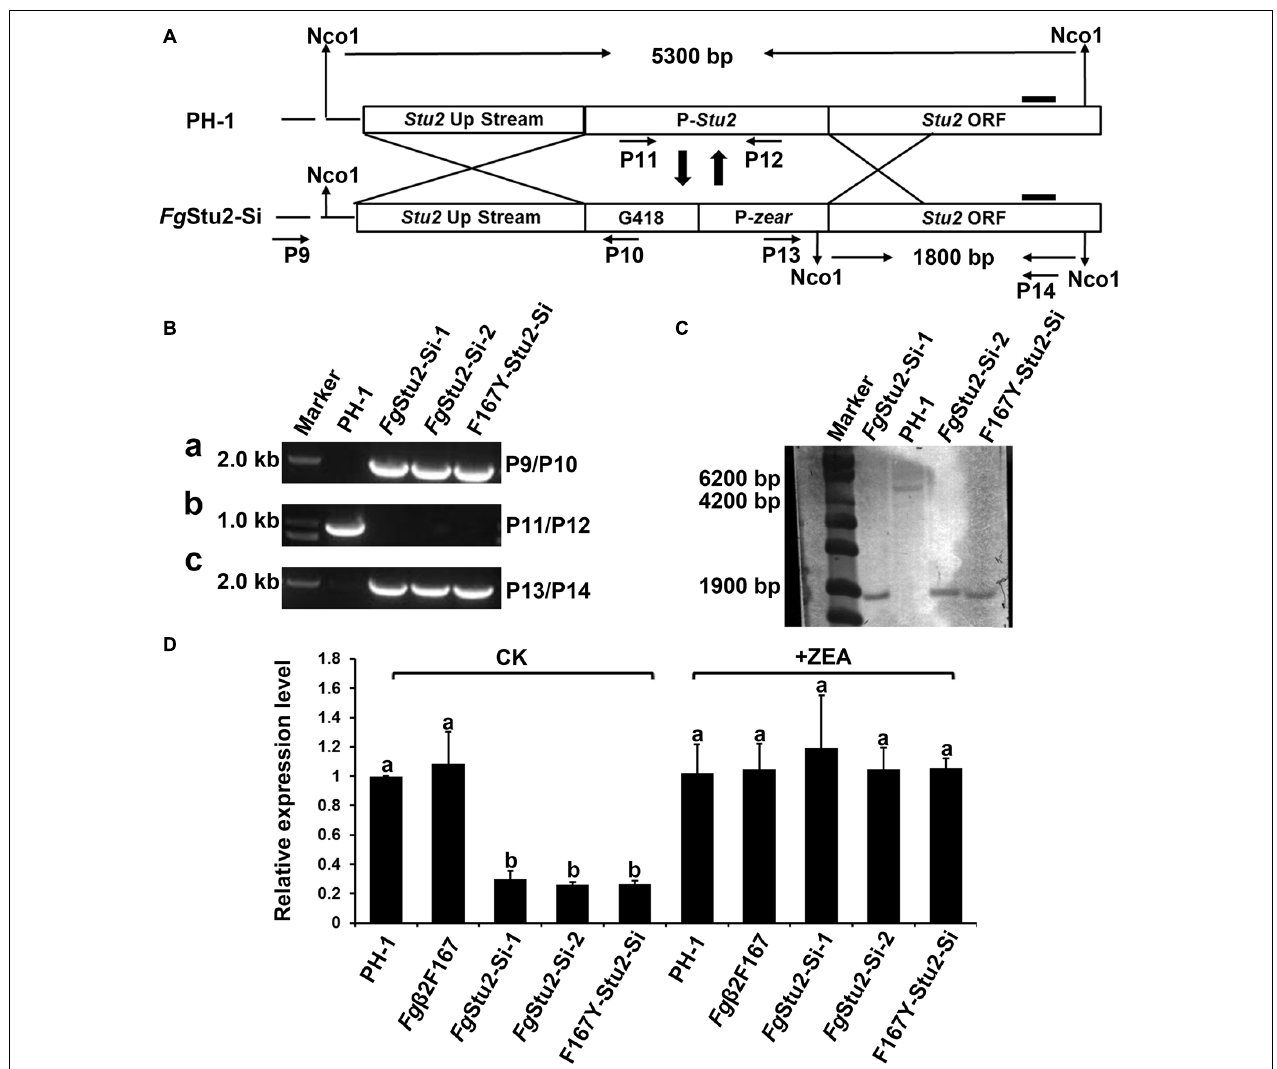
FIGURE 4 | Promoter replacement strategy and identification of promoter replacement mutant of Fg Stu2 gene. (A) Schematic of promoter replacement of Fg Stu2 gene. (B) Polymerase chain reaction (PCR) identification of Fg Stu2 promoter replacement mutants. (a) a 1.9 kb fragment was amplified by primers P9/P10 indicates G418-Pzear fragment integrated at the 3 (cid:48) -terminal of up-stream non-coding sequence of FgStu2 gene. (b) a 0.9 kb fragment could not amplified by primers P11/P12 indicates original promoter of Fg Stu2 has been substituted with G418-Pzear. (C) a 1.8 kb fragment was amplified by primers P13/P14 indicates that G418-Pzear integrated at the 5 (cid:48) -terminal of Fg Stu2 coding sequence (CDS). (C) Southern blot identification of Fg Stu2 promoter replacement mutants. (D) Real-time quantitative PCR identification of Fg Stu2 promoter replacement